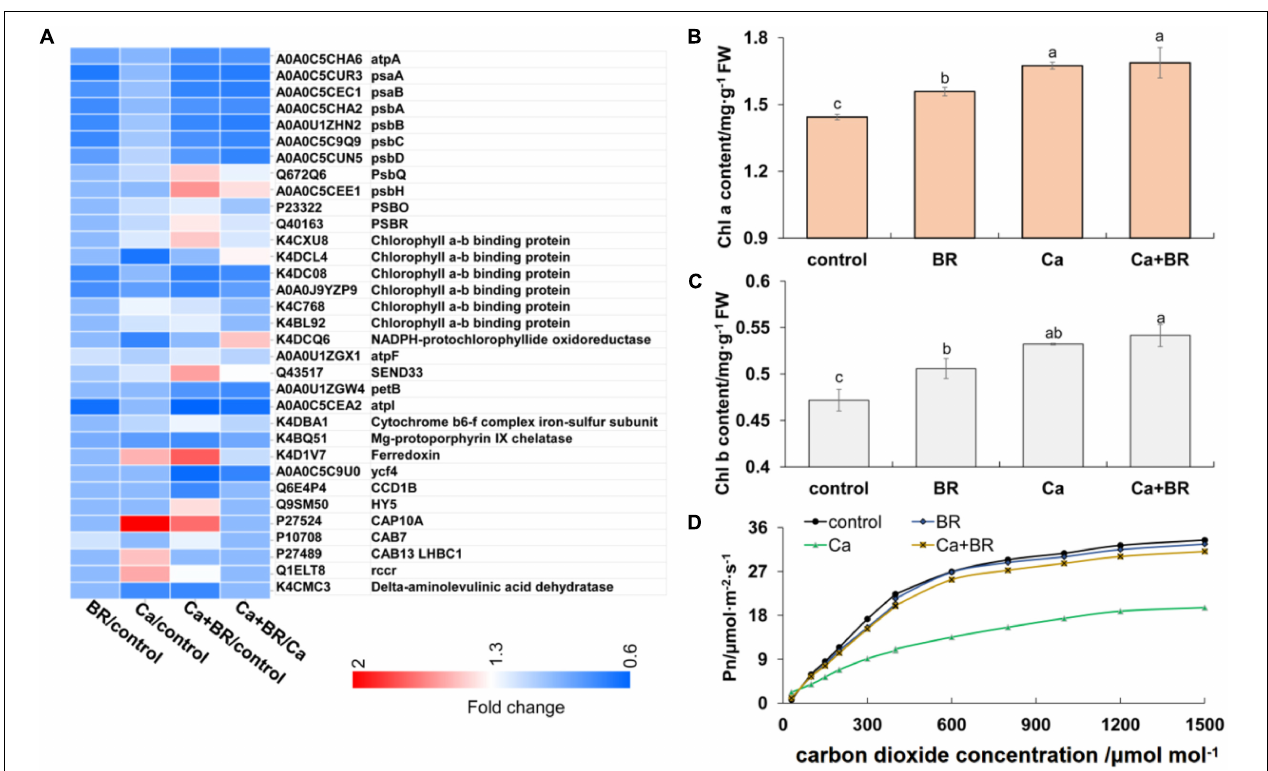
FIGURE 3 | BR alleviated Ca(NO 3 ) 2 -inhibited photosynthesis in tomato seedlings. (A) Heatmap of the differentially changed proteins involved in photosynthesis. (B) Chlorophyll a content. (C) Chlorophyll b content. (D) Photosynthesis-CO 2 response curve. BR, 0.1 µ mol/L BR; Ca, 100 mmol/L Ca(NO 3 ) 2 ; Ca+BR, 100 mmol/L Ca(NO 3 ) 2 stress plus foliar spraying with exogenous BR. Each data point represents the mean of three independent biological replicates (mean ± SD). Different letters above the bars indicate statistically significant differences ( P < 0.05).